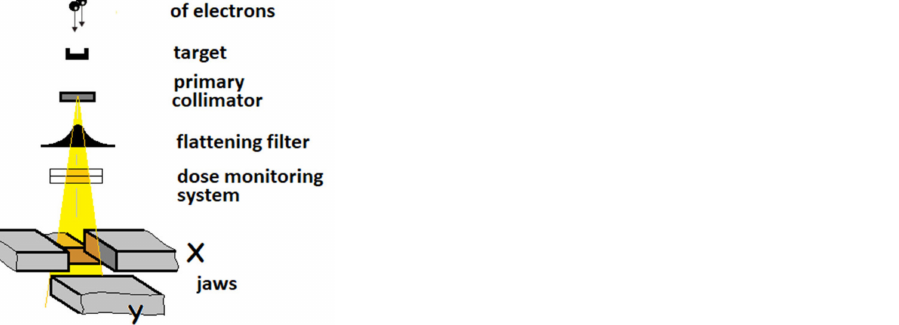
Figure 5. Diagram of the beam collimation system in a standard medical accelerator—Linac